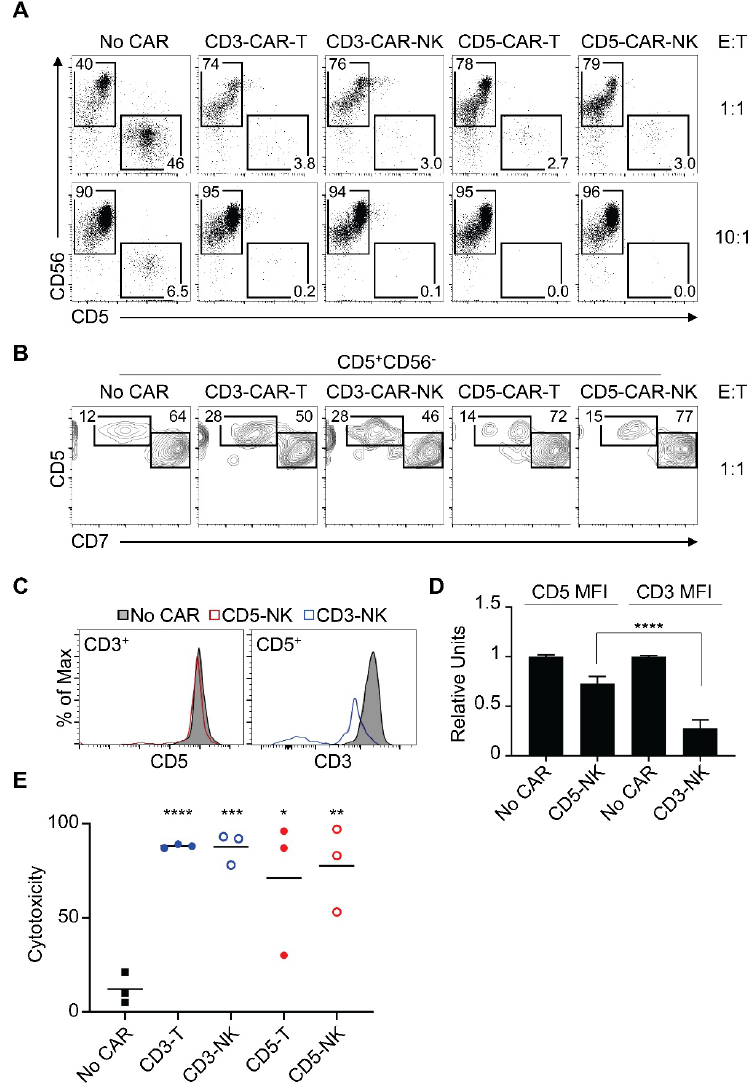
Figure 3. CD3 and CD5 CARs eliminate malignant T cells. ( A ) In vitro cytotoxic assay after incubation of the indicated CAR NK cells with T-cell lymphoma samples at the indicated effector-to-target ratios. This graph represents one of three independent experiments with three different patient samples. ( B ) FACS analysis of the phenotype of remaining target cells after coculture with the indicated CAR NK cells. ( C ) FACs analysis of cell surface levels of remaining primary T cells after coculture with CAR NK cells. Analysis of CD5 levels were performed on gated CD3+ cells and analysis of CD3 levels were performed on gated CD5+ cells. ( D ) Quantitation of cell surface levels represented in ( C ), from three independent experiments. To allow direct comparison of CD5 and CD3 MFI levels, relative MFI values were derived by dividing MFI levels of either CD5 or CD3 to the average of MFI levels in the No-CAR condition. ( E ) Quantitation of cytotoxicity represented in ( A ) in three patient samples. Each dot represents a patient sample. Cytotoxicity was analyzed as reduction in lymphoma cell numbers after coculture with effector NK cells. Unpaired t -test, n = 3. p < 0.05 (*), p < 0.01 (**), p < 0.001 (***), p < 0.0001